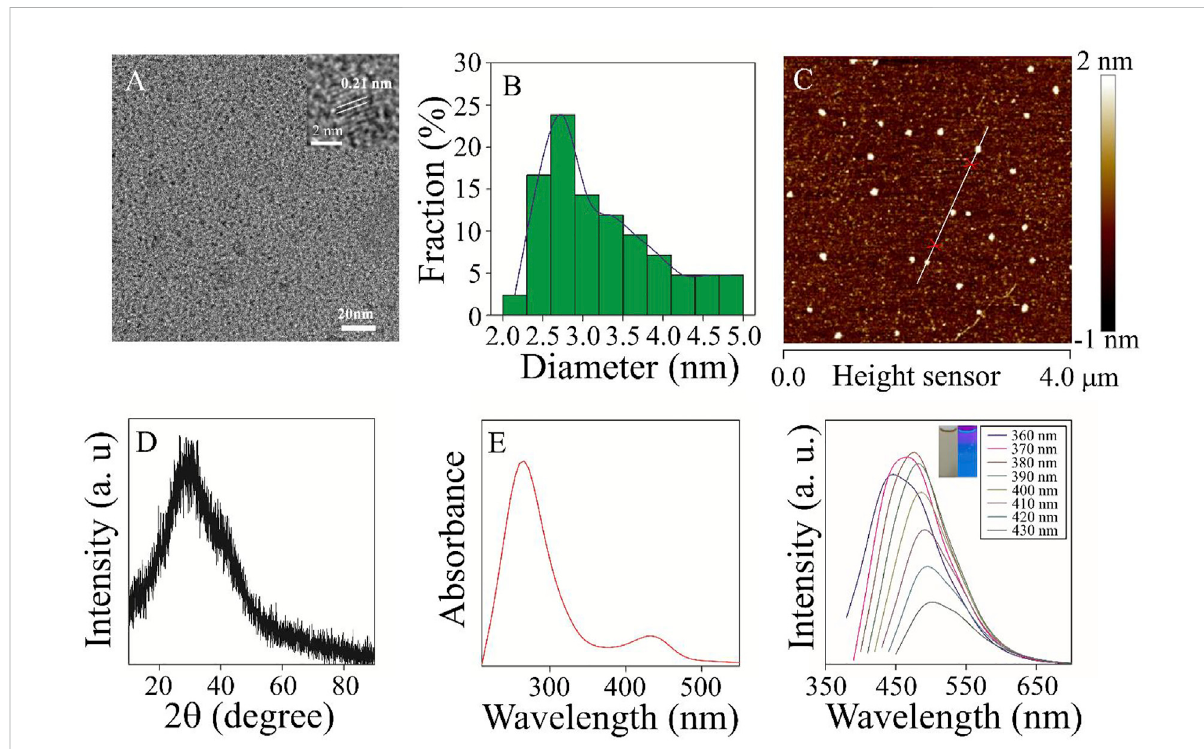
The morphology andopticalproperties ofthesamples werecharacterized (A) TEMand HRTEM(inset) images of Mn 3+ /Mn 4+ ion-dopedCDs (B) TEM particle size distribution. (C) AFM image of Mn 3+ /Mn 4+ ion-doped CDs (D) XRD image of Mn 3+ /Mn 4+ ion-doped CDs. (E) UV-vis absorption spectra of Mn 3+ /Mn 4+ ion-doped CDs. (F) The fl uorescence emission spectra of Mn 3+ /Mn 4+ ion-doped CDs at different excitation wavelengths of 340 – 440